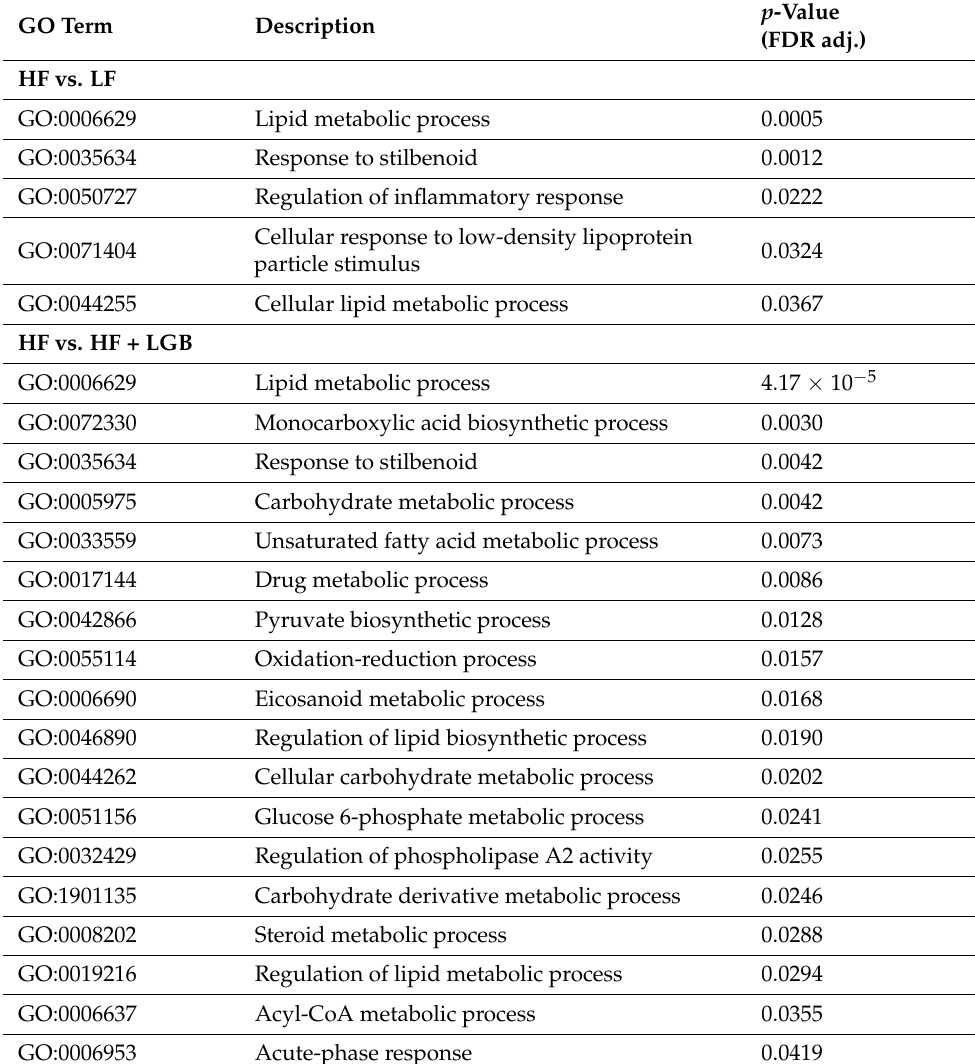
Table 6. Gene Ontology (GO) terms significantly enriched among the significantly differentially expressed genes. Gene lists are obtained from the DAVID tool and reduced with